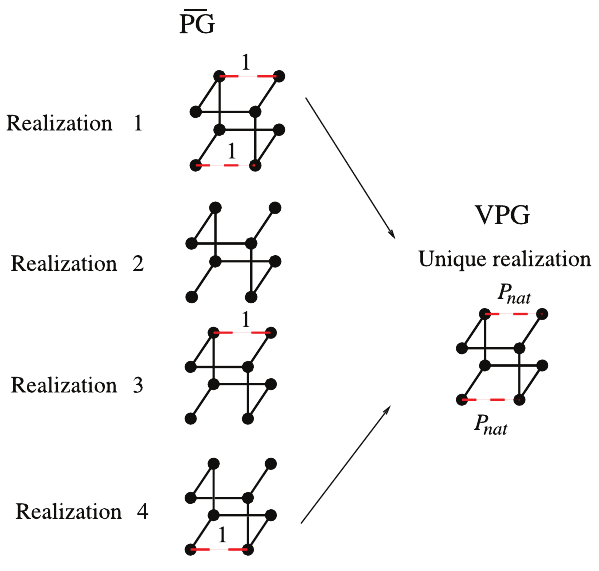
Figure 1. The respective network descriptions are compared. Equilibrium rigidity properties (designated as PG ) are calculated by averaging across an ensemble of binary networks where H-bonds are either present or not. Conversely, the VPG describes the network with H-bond probabilities.